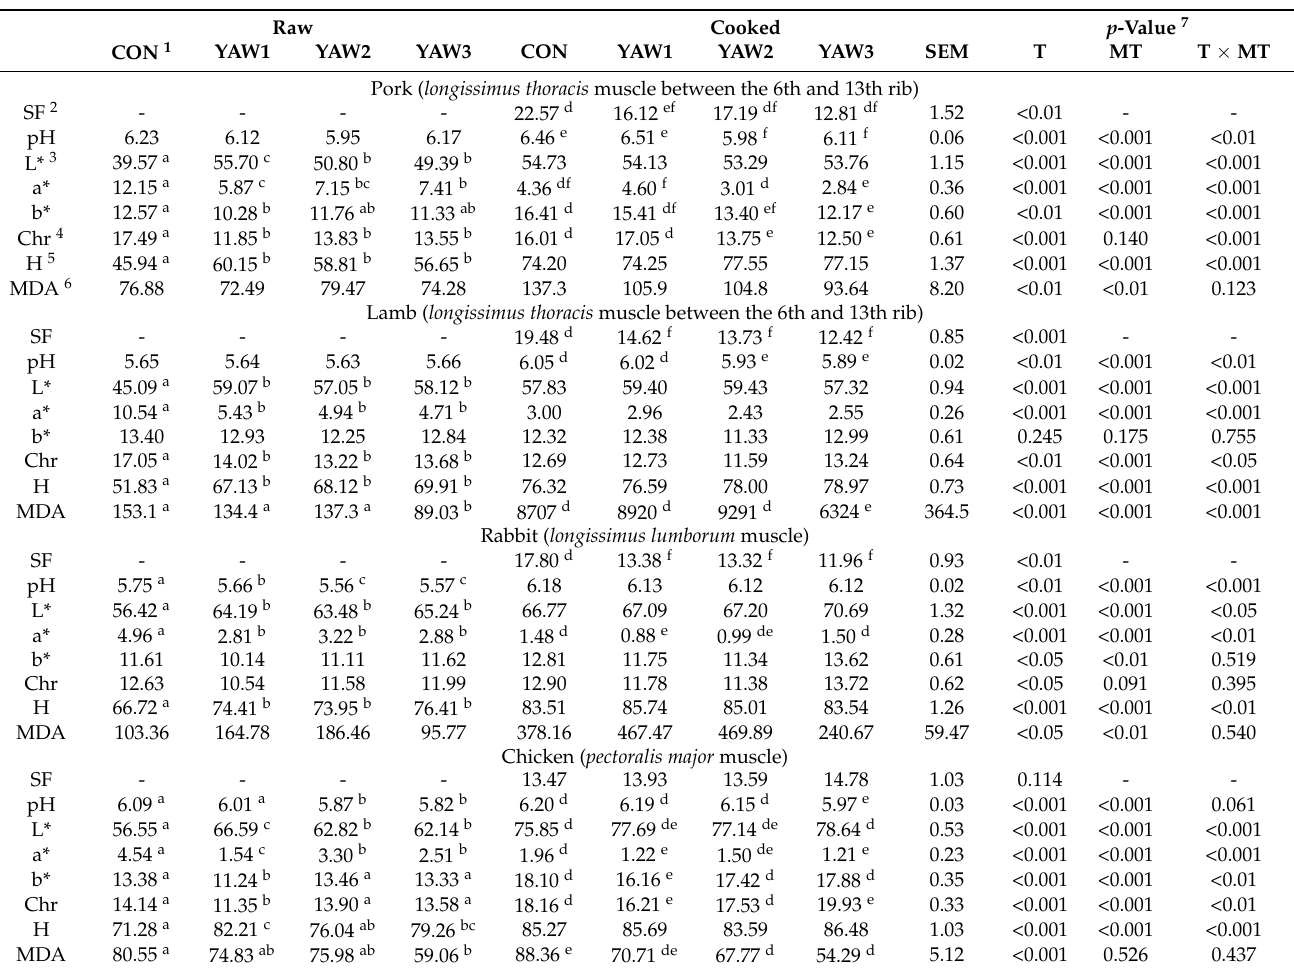
Table 1. Effects of YAW marination on quality characteristics and oxidative stability of different raw and cooked meat types (LS means ±